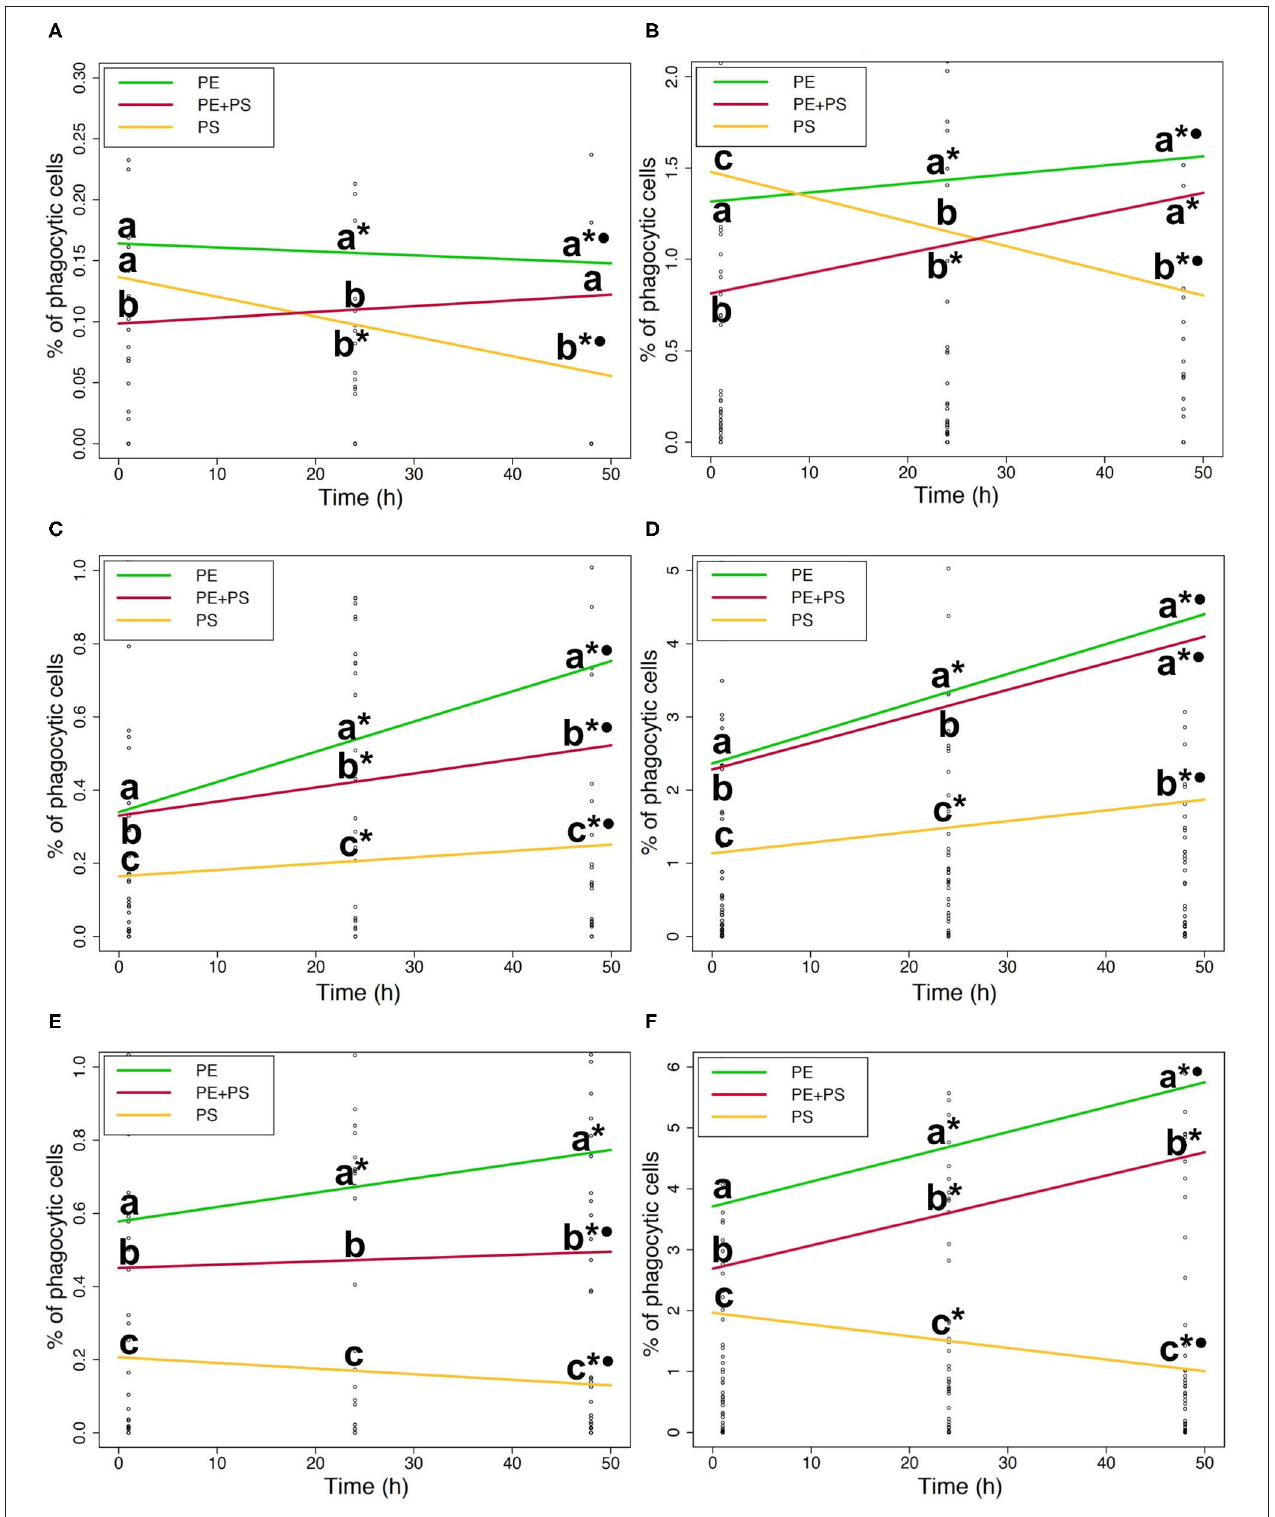
FIGURE 4 | (A) . Phagocytic ability of DI cells to microplastic (5 mg/L). (B) . Phagocytic ability of DI cells to microplastic (50 mg/L). (C) . Phagocytic ability of blood cells to microplastic (5 mg/L). (D) . Phagocytic ability of blood cells to microplastic (50 mg/L). (E) Phagocytic ability of HK cells to microplastic (5 mg/L). (F) Phagocytic